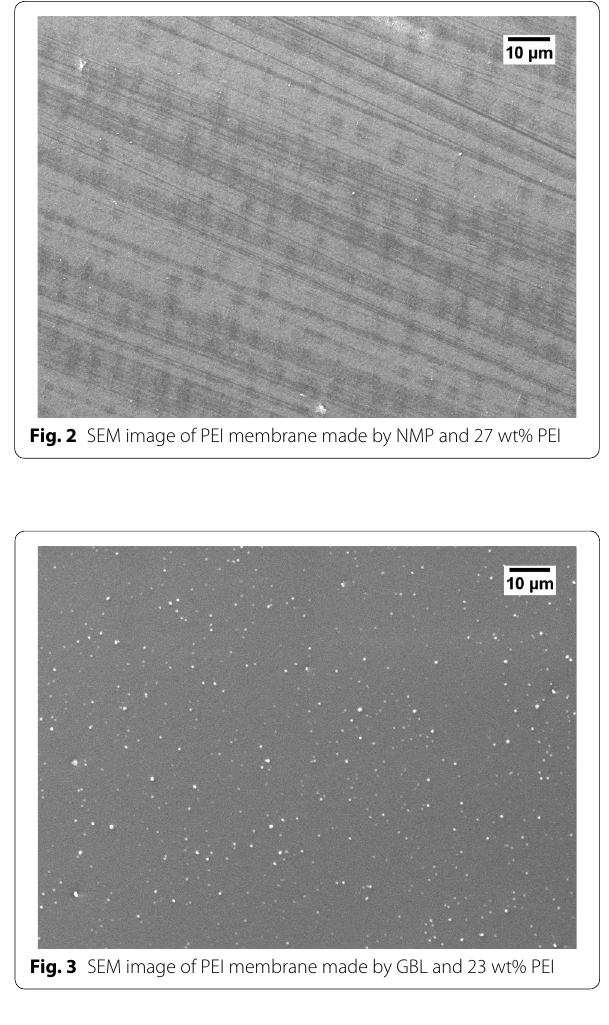
Table 5 Thickness of the final membranes after tape